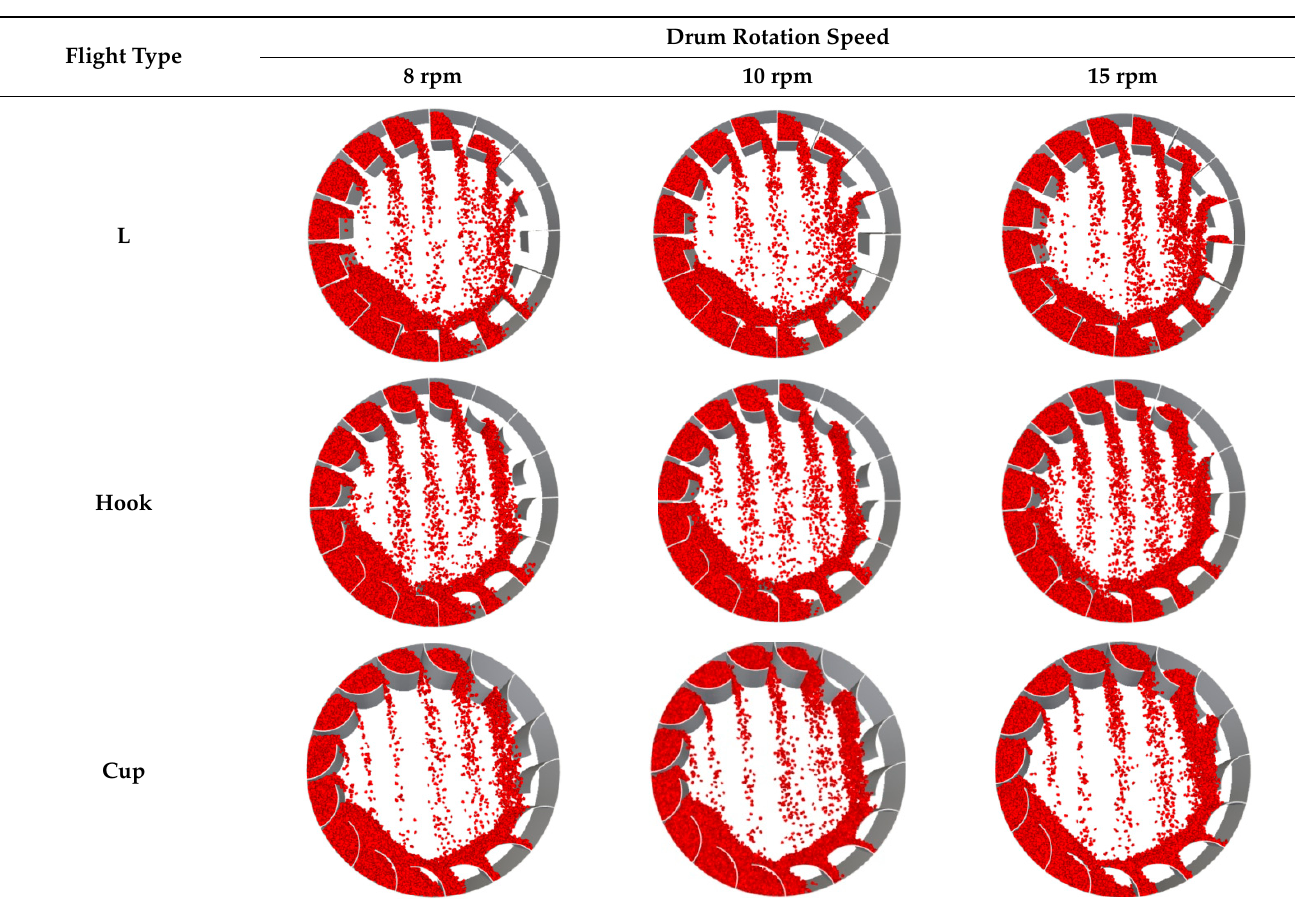
Table 7. The image of the particle dispersion mode for different flight shapes and 20% drum filling